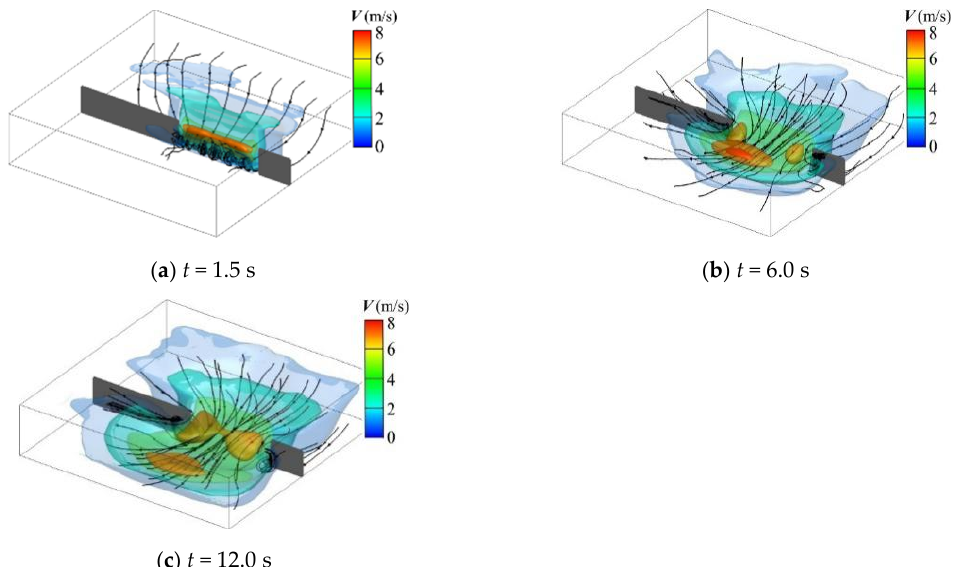
Figure 4. Velocity of partial dam-break flows, ( a ) t = 1.5 s, ( b ) t = 6.0 s, ( c ) t = 12.0 s. Water 2018 , 10 , x FOR PEER REVIEW